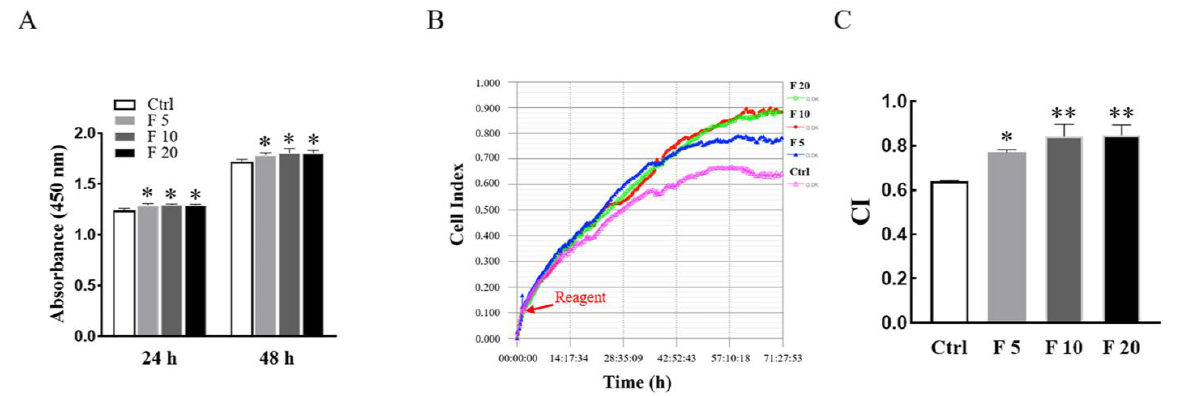
Figure 2. Effects of FST on viability and proliferation of primary cultured trophoblasts of mice. ( A ) The primary cultured trophoblasts of E8.5 mice were treated with FST for 24 h and 48 h, respectively, and the viabilities of cells were examined by the CCK-8 assay. The graph shows the absorbance of OD450 ( n = 6). * p < 0.05, compared with control. ( B ) The proliferation of primary cultured trophoblasts of mice treated with FST for 72 h was examined by RTCA. The red arrow represents the dosing point. Ctrl: 2% FBS culture medium control. F5: 5 ng/mL of FST. F10: 10 ng/mL of FST. F20: 20 ng/mL of FST. ( C ) The graph showed the average cell index and standard deviation ( n = 3). * p < 0.05, ** p < 0.01 compared with control.